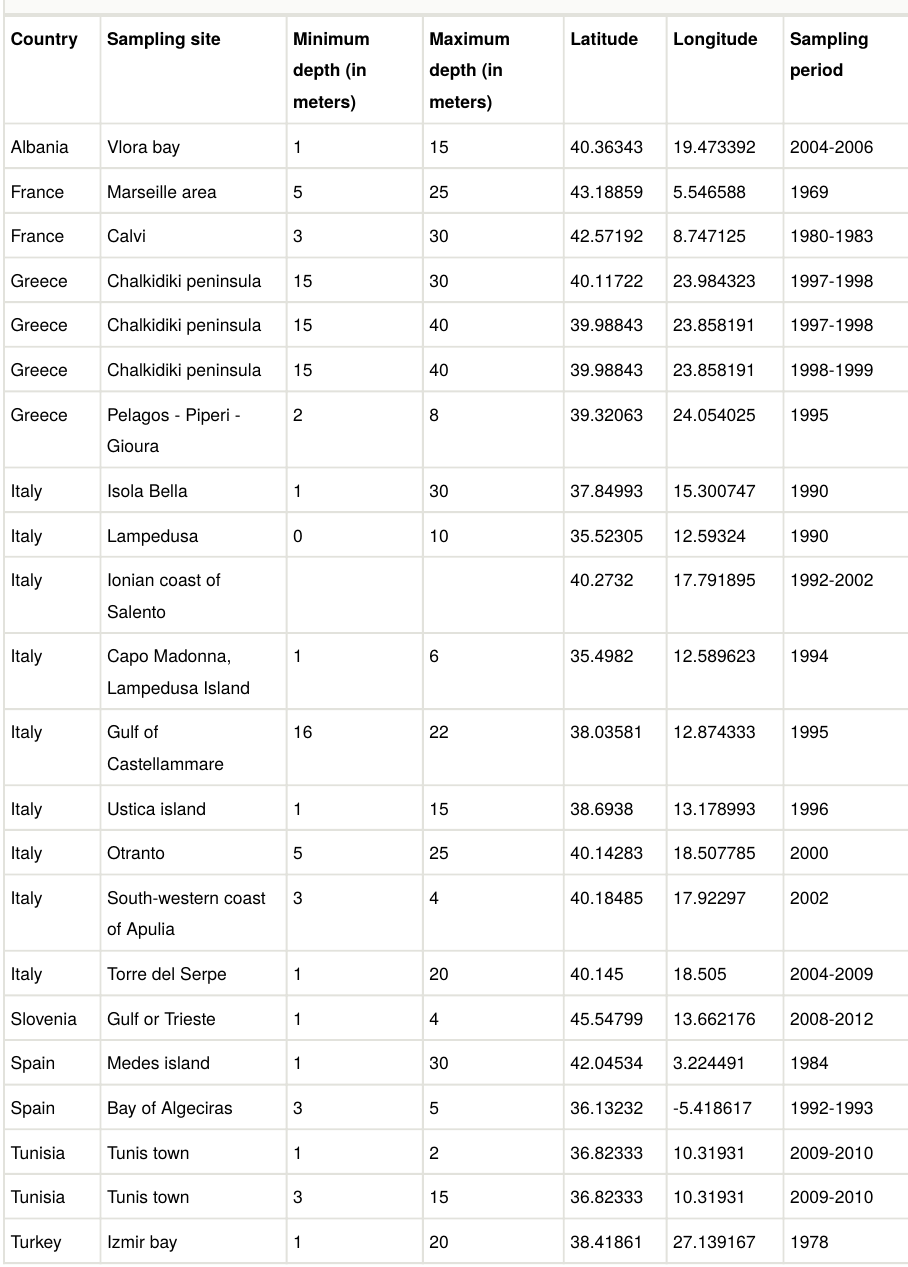
Table 1. Coordinates, depth and sampling dates of the